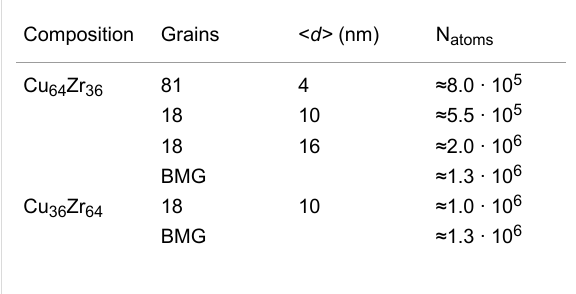
Table 1: Number of glassy grains, average grain diamater and total number of atoms used for the construction of